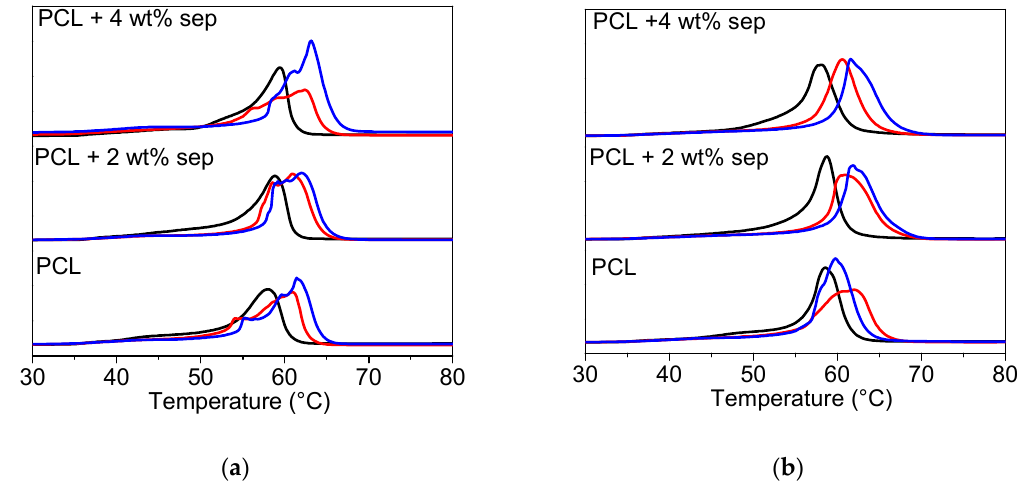
Figure 7. Heating trajectories obtained from DSC experiments. ( a ) Samples cooled with open chill rolls. ( b ) Samples cooled with closed chill rolls. Solid black lines are for undrawn films, red lines are intermediate, and blue lines are for highly drawn tapes.